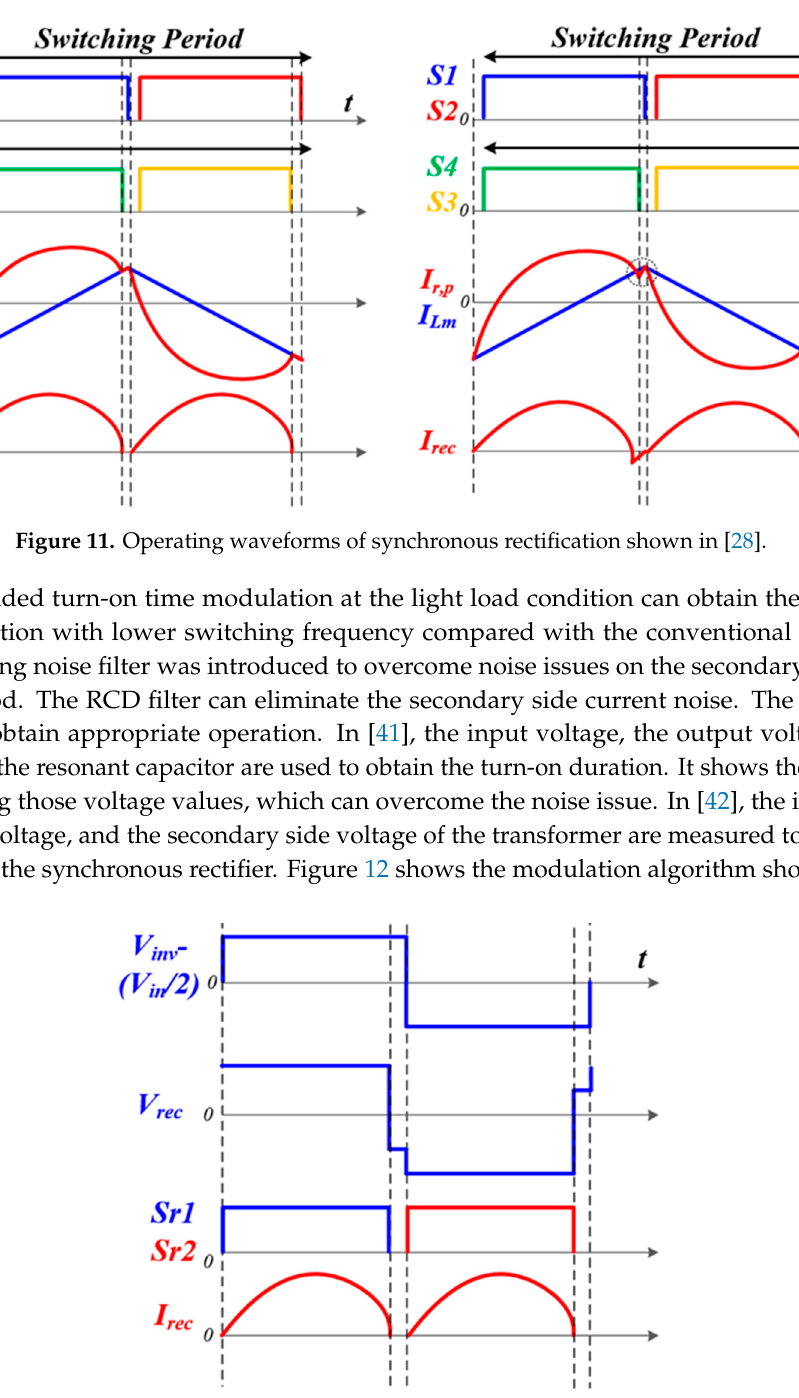
Figure 10. Operating waveforms of synchronous rectification shown in [38].